Question: In one sentence, what is this figure communicating?
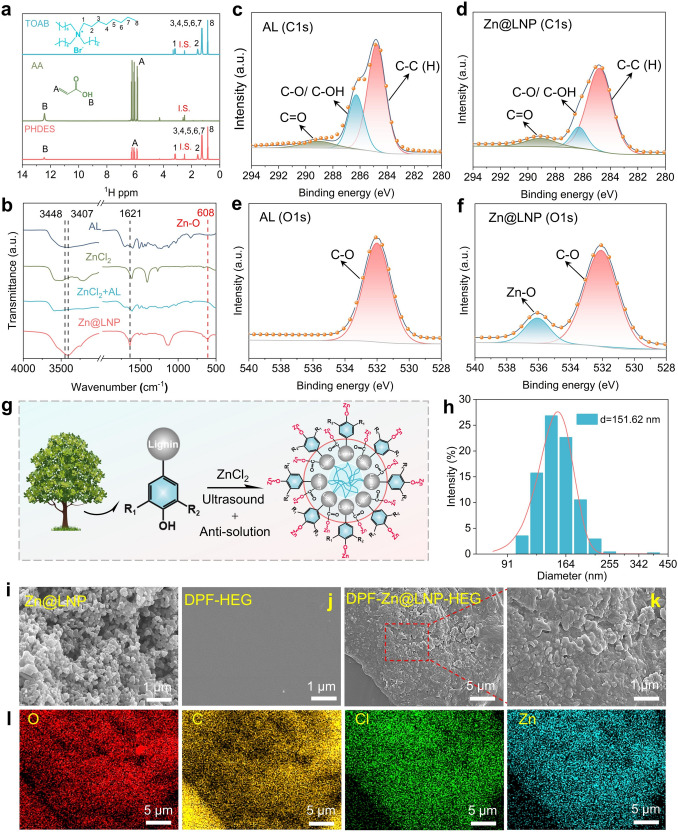
Answer: a 1 H NMR spectra of TOAB, AA, and PHDES. b FTIR spectra of AL, ZnCl 2 , ZnCl 2 + AL, and Zn@LNP. High-resolution XPS spectra of C 1 s c, d and O 1 s e, f regions for AL c, e and Zn@LNP d, f. g Schematic illustration of the Zn@LNP self-assembly process. h Particle size distributions of Zn@LNP. Cross-sectional SEM images of i Zn@LNP, j DPF-HEG, and k DPF-Zn@LNP-HEG, with l EDS elemental mappings of O, C, Cl, and Zn